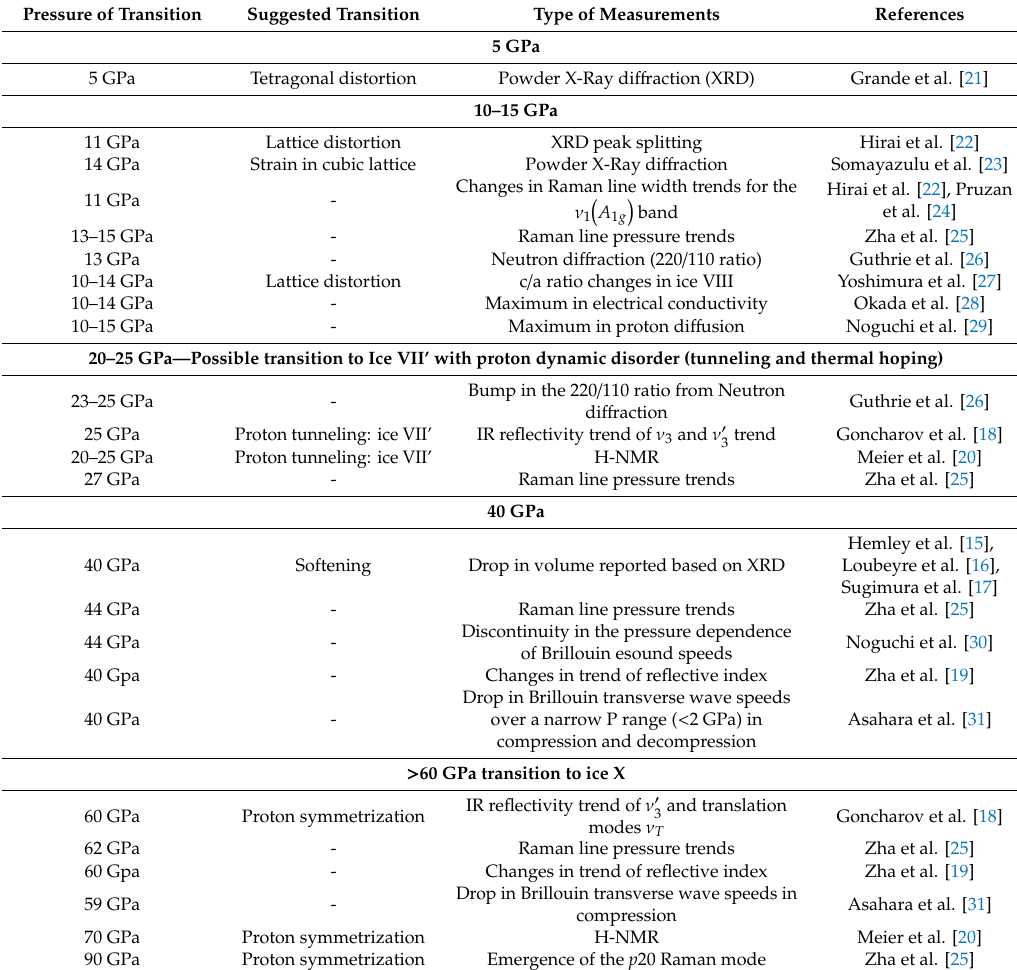
Table 1. Reported transitions in ice VII and ice